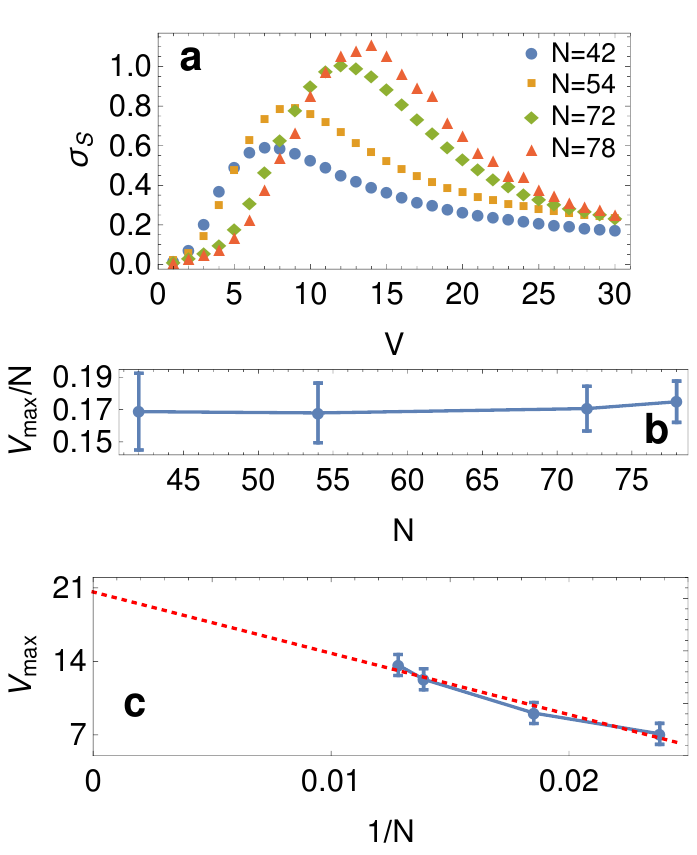
Figure 8: Panel a . Standard deviation of the entanglement entropy as a function of disorder for different sample sizes. Panel b . Position of the maximum entanglement entropy standard deviation V scaled by the system size N , as a function of the sys- max tem size. For the range of accessible sizes, V has an approximately linear increase max with system size. Panel c . A different attempt at scaling the position of the maximum, by plotting as a function of the inverse of the system size 1 / N . We show a linear fit as a dotted red line, which extrapolated to 0 would give an estimated transition at V = 20 ± 2 (see the main text for a discussion on the quality of this extrapolation). with cluster size (panel b ) as well as 1 / N extrapolation of this position (panel c ). While the former seems to suggest that for the entanglement entropy, system sizes up to N = 78 do not show convergence to a finite transition value, we cannot exclude from the latter plot that it extrapolates to a finite value (e.g. using a 1 / N fit). We note that it is especially difficult to be definitive in this extrapolation given that the position of the peak is only known within the precision of our disorder grid. Even being quite dense, a small change (by ∆ V = 1) of the position of the peak for the larger cluster can considerably change the extrapolation.